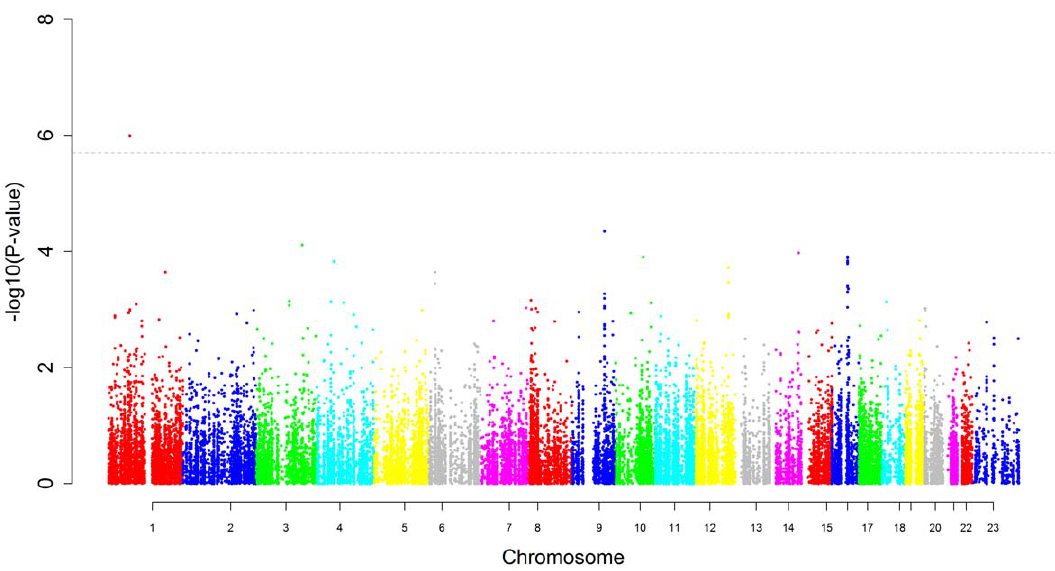
Figure 4. Manhattan plot for obstructive sleep apnea in the European ancestry population. This figure plots the association results for all SNPs against an apnea hypopnea index of 15 or greater among those of European ancestry. The y-axis displays the -log(p-value), the x-axis the SNP position on each chromosome. The dotted line represents the threshold for statistical significance based on the number of independent comparisons being made.